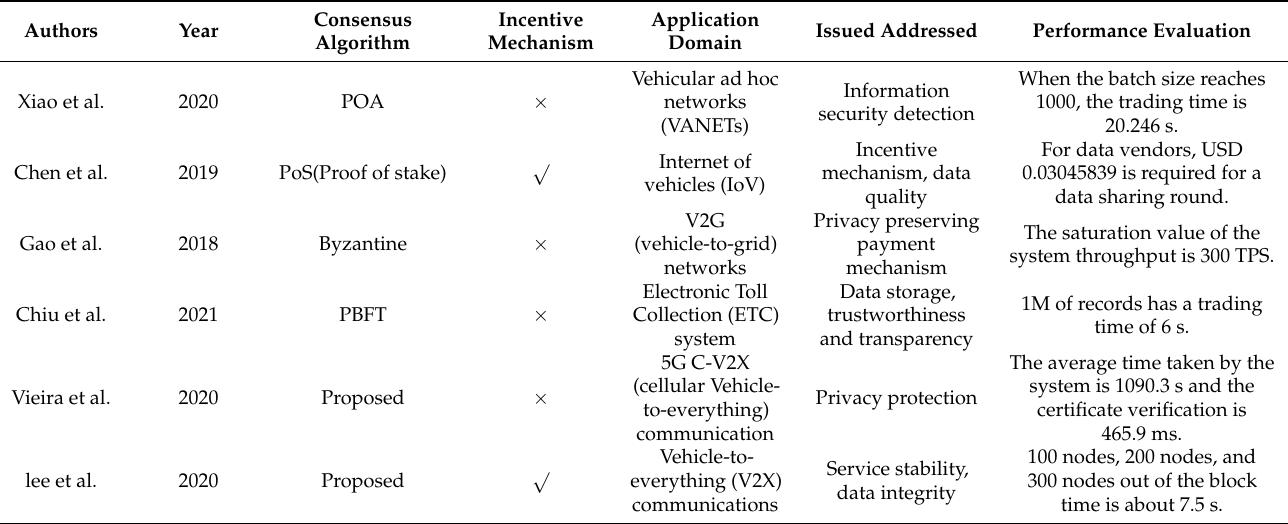
Table 7. Differences between schemes of smart transportation (continue Table